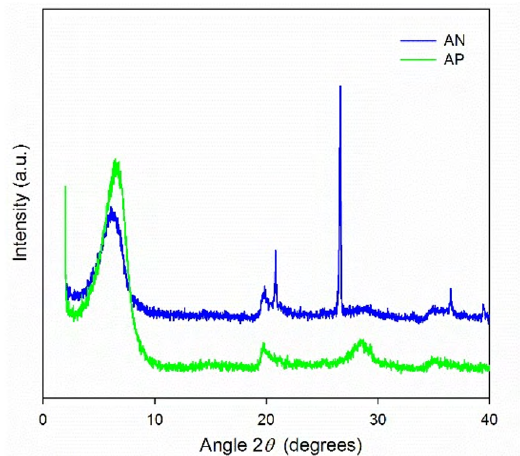
Figure 2. X-Ray diffratograms of natural (AN) and purified (AP) clays over a wider range of 2 θ .